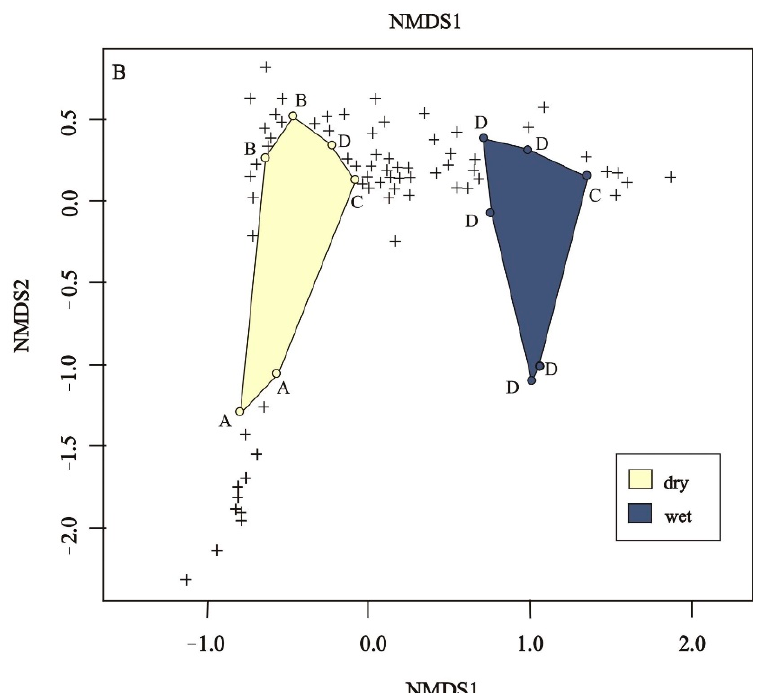
Figure 4. Non-metric multidimensional scaling (NMDS, stress-value = 0.125) diagram showing ( A ) = similarity (Bray–Curtis index) of plant community structure for 4 habitat types: A = forests (green); B = clearings (olive); C = infiltration ditches (sky-blue); D = infiltration basins (navy blue); ( B ) = distribution of species of dry and wet habitats: A = forests; B = clearings; C = infiltration ditches; D = infiltration basins.